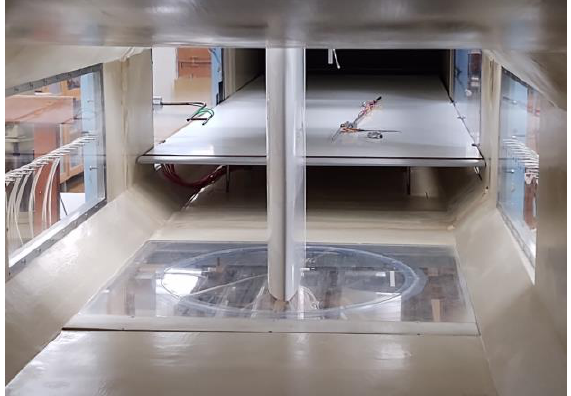
Fig. 2. Front view on the model (placed vertically) inside the test-section of the windtunnel.